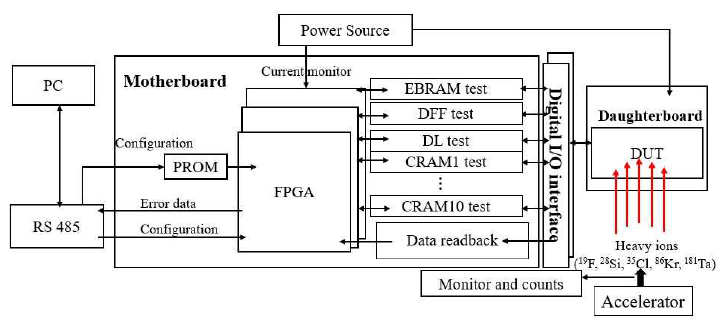
Figure 6. Block diagram of the testing